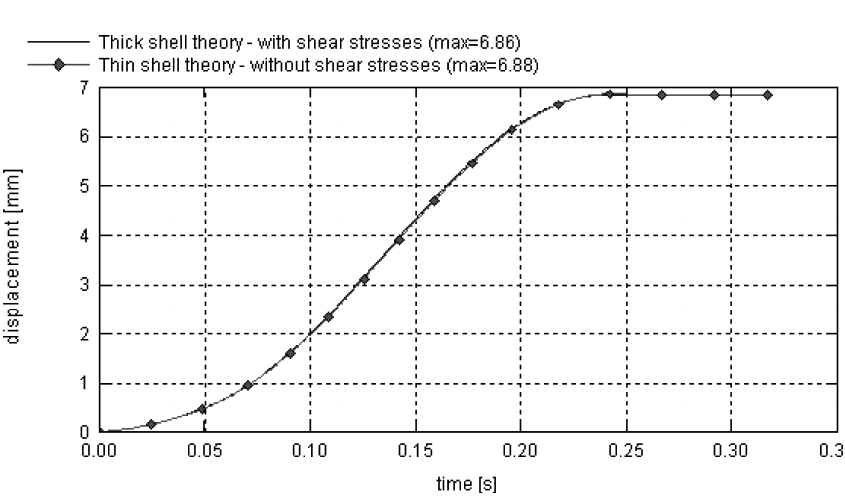
Fig. 15. Radial displacements for a cylinder subjected to a ring of pressure ( t = 0 . 5 mm